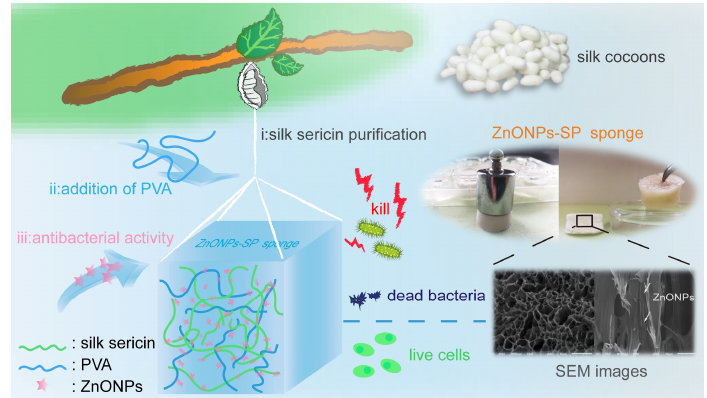
Figure 1. Illustration of the preparation and evaluation of ZnONPs-SP sponge.